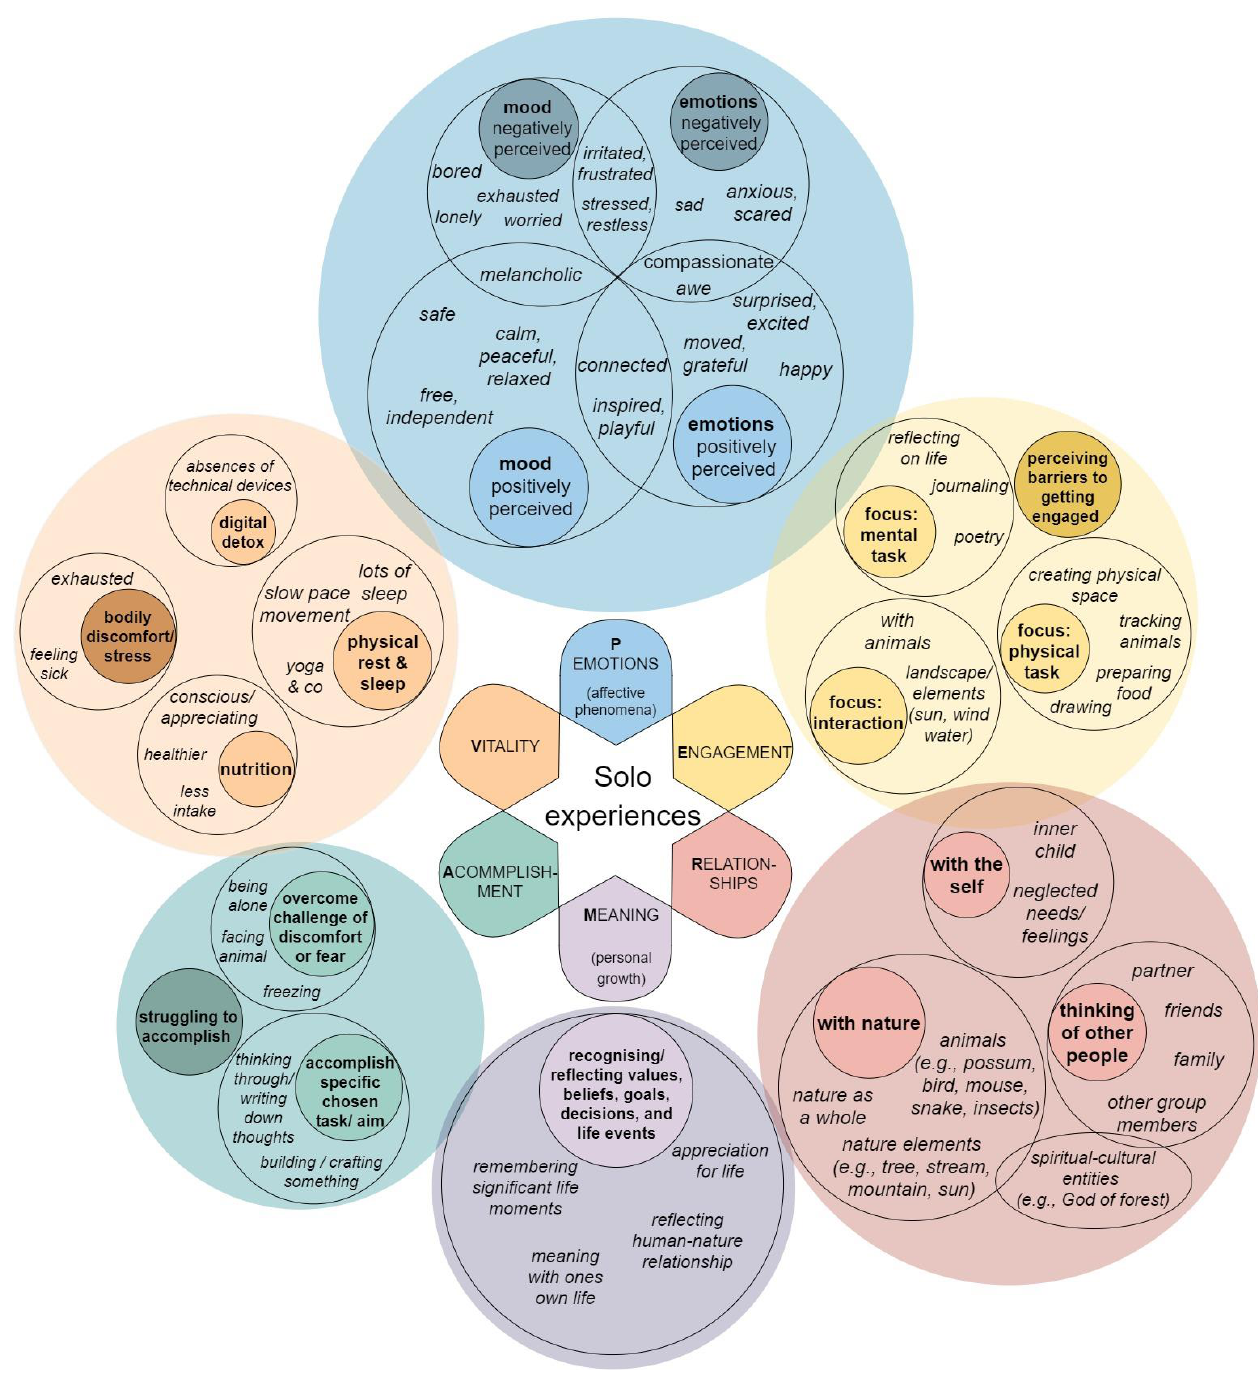
Figure 2. Well-being pathways, applying PERMA-V: (Positive) emotions, Engagement, Relationship, Meaning, Accomplishment and Vitality, including subcategories. The relative visual size of the circles at each level reflects the relative frequency of segments coded into each category.